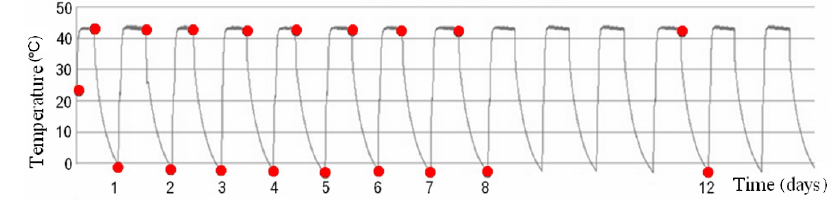
Figure 2. Temperature conditions during the first 14-days of test.